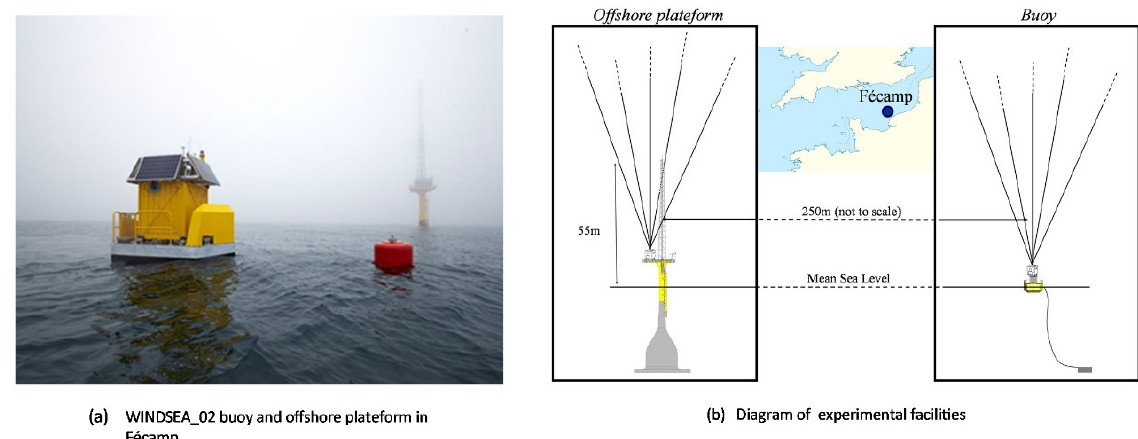
Figure 2. Presentation of the experimental means deployed on the site 14 km off the coasts of Fécamp. ( a ) Photograph of the WINDSEA_02 buoy (in the foreground) accompanied by the wave buoy (in red). The fixed platform is visible in the background. ( b ) Diagram of the experimental means, the dimensions are not respected and the LIDAR is not to scale.